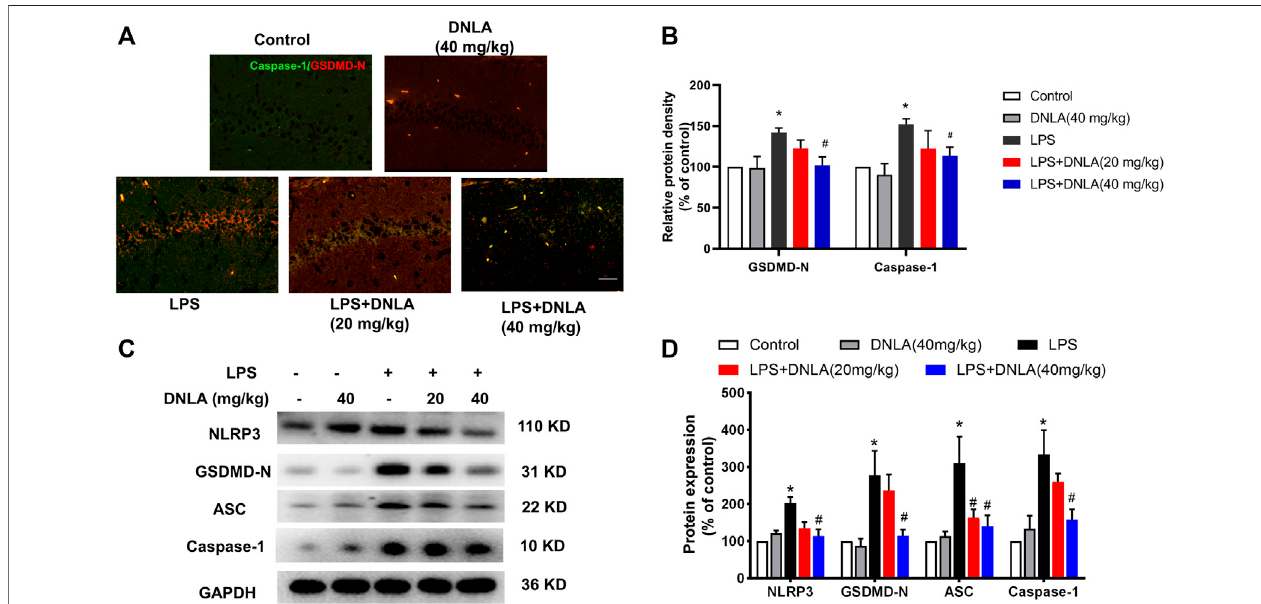
FIGURE 4 | DNLA inhibited NLRP3/GSDMD signaling pathway activation. After DNLA treatment for 14 days, the protein expressions of GSDMD and NLRP3 in hippocampus CA1 were measured by immuno fl uorescence staining. Scale bar = 50 μ m (A) . The green color indicated caspase-1-positive cells, and red color exhibited GSDMD-N-positive cells. Quantitative analysis of protein density of GSDMD-N and caspase-1 (B) . Protein expressions of GSDMD-N, caspase-1, NLRP3, and ASC in thehippocampusweremeasuredbyWesternblottingassay (C) .QuantitativeanalysisoftheexpressionofGSDMD-N,caspase-1,NLRP3,andASC;thereference valueofthe protein/GAPDH wasthe ratioofthe control group (D) . Datawere expressed asmean± SEM, n =3 – 4.* p < 0.05comparedwith thecontrol group; # p < 0.05 compared with the LPS-treated group.